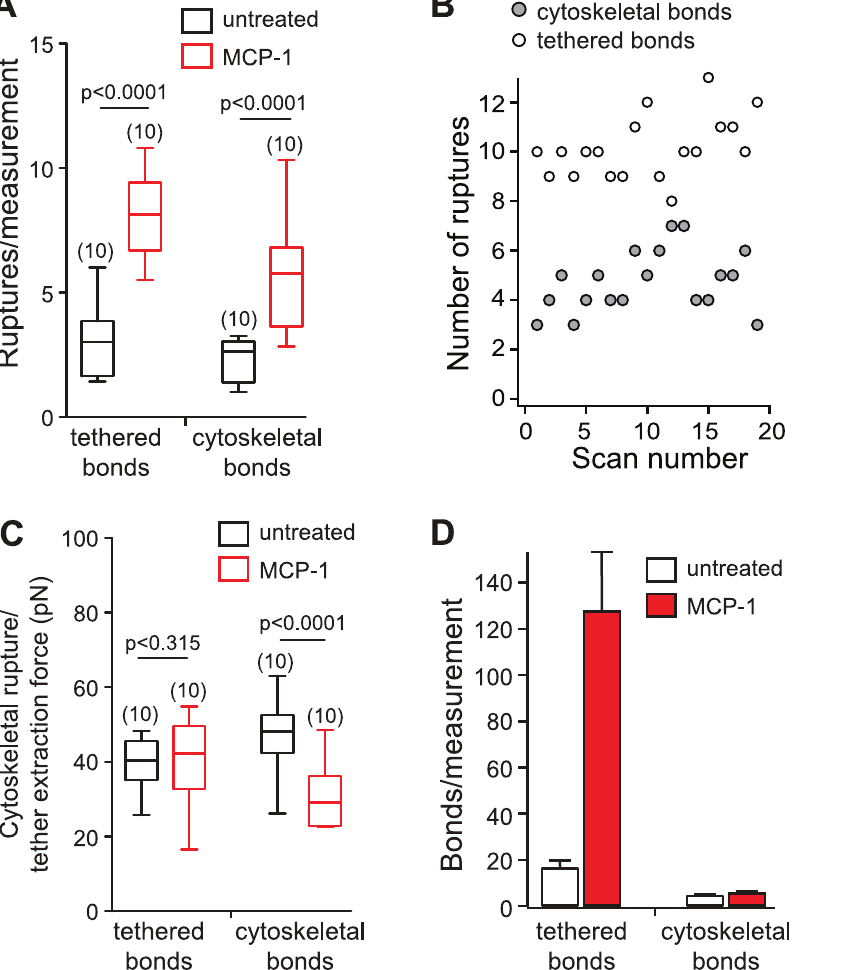
Figure 2. MCP-1 enhanced the number of cytoskeleton-anchored and membrane tethered a 4 b 1 /VCAM-1 ruptures per AFM measurement. (A) Box-and-whisker plot of the number of cytoskeleton-anchored and membrane-tether bond rupture events in AFM whole cell measurements with or without co-immobilized MCP-1. (B) Variation in the number of cytoskeleton-anchored and membrane-tethered ruptures from consecutive measurements. (C) Box-and-whisker plot of the extraction forces of membrane-tethers and cytoskeleton-anchored bonds rupture forces measured from whole cell adhesion measurements on untreated cells or cells stimulated with MCP-1.Measurements were acquired from 10 cells. Two-tailed Mann-Whitney tests were performed comparing untreated to stimulated cells. (D) Predicted number of cytoskeleton-anchored and membrane tethered a 4 b 1 /VCAM-1 bonds associated with the attachment of untreated and MCP-1stimulated cells to immobilized VCAM-1. Error bars assigned to membrane-tethered complexes were based on the estimated number of complexes per tether (Figure 5C). Error bars assigned to the cytoskeleton-anchored complexes were based on the s.e.m. of the number of cytoskeleton-anchored ruptures per measurements.